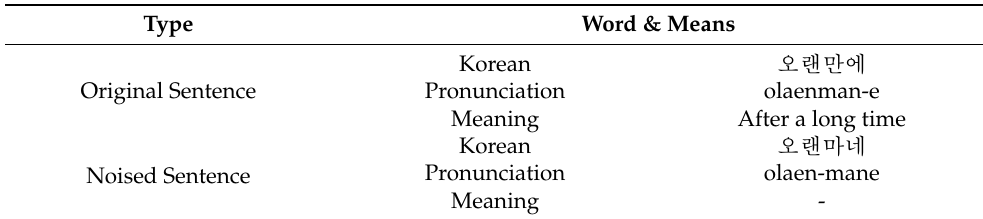
Table 1. Examples of Grammatical Noise Implantation Rules using the Pronunciation Mechanisms of Korean.